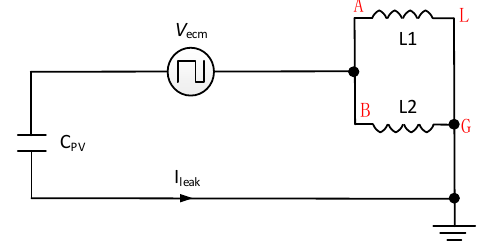
Figure 2. CM current path for transformerless PV inverter.